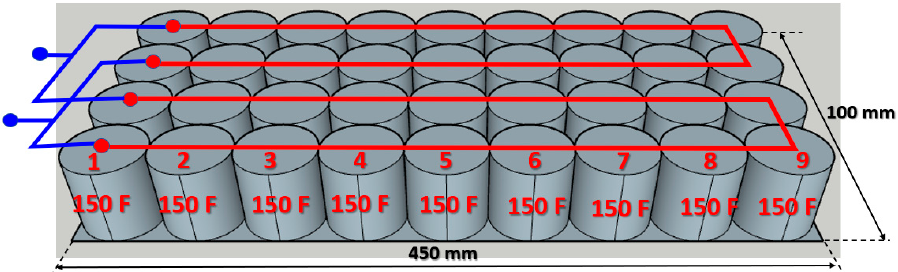
Figure 20. SC array: distribution and dimensions.